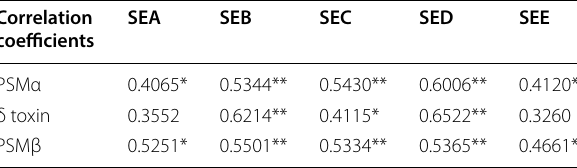
Table 2 Correlation coefficients between SEs and PSMs levels in foodborne S. aureus